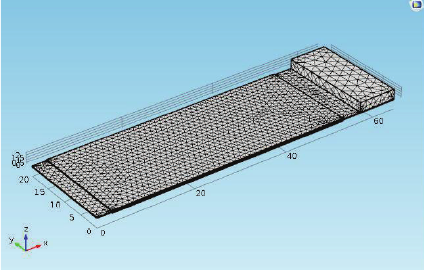
Figure 5: Finite element model of the harvesting structure by COMSOL